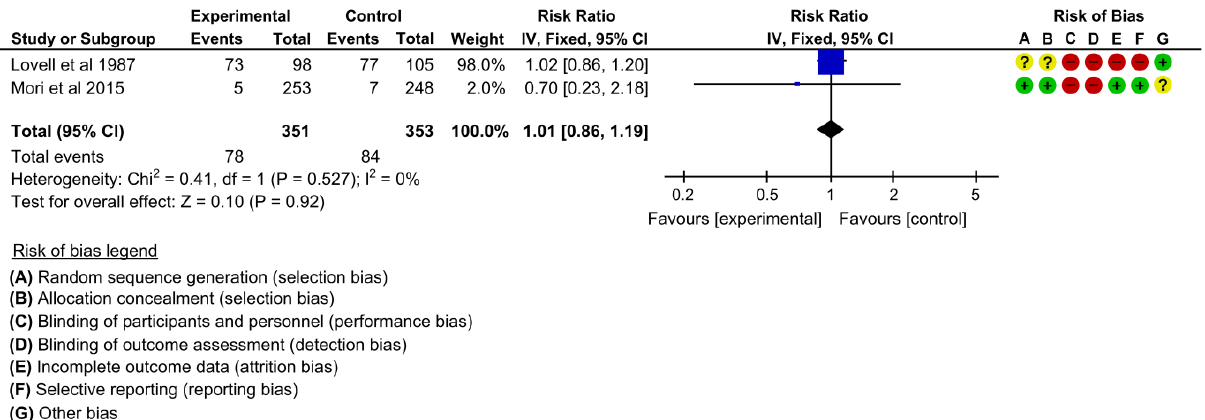
Figure 8. Meta-analysis for the effect of MCH handbook interventions vs. standard care on maternal smoking [19,22]. Red color with a − symbol means a high risk of bias, yellow color with a ? symbol means an unclear risk of bias, and green color with a + symbol means a low risk of